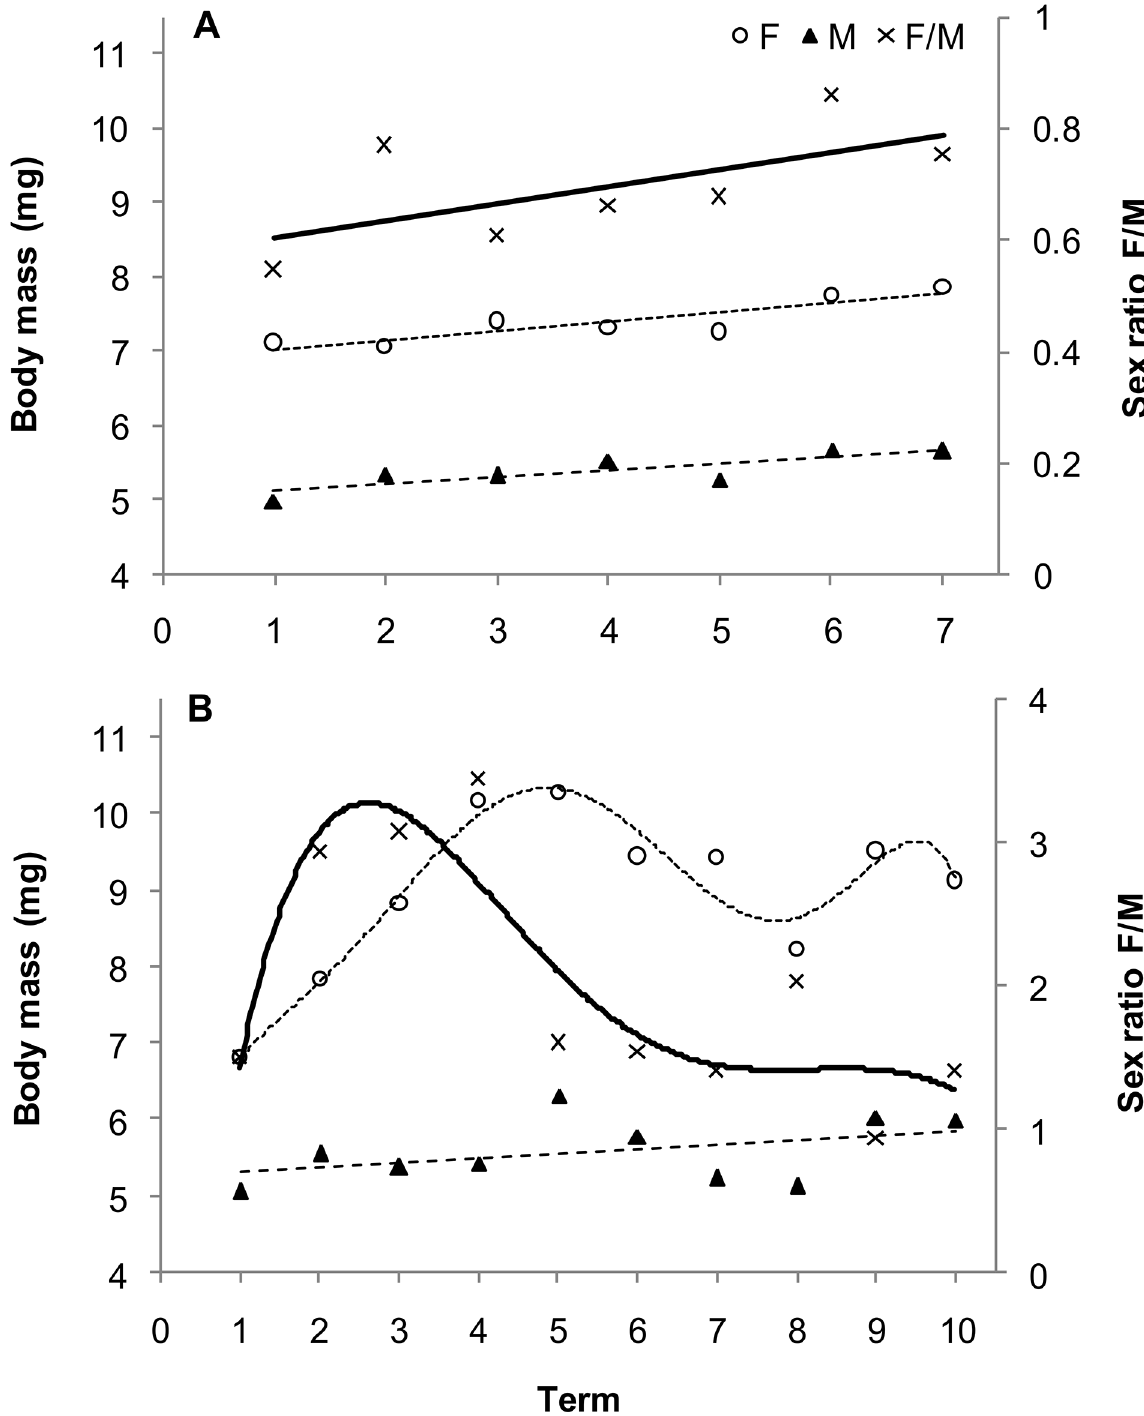
Fig 4. Body mass and sex ratio of current-year (A) and 1-year-old (B) Altica brevicollis coryletorum beetles over time. Numbers 1 – 7 and 1 – 10 indicate successive dates of insect collection (see Materials and Methods). One-way ANOVA was used to determine the effect of term on females (current-year, R 2 = 0.0824, P < 0.0001; 1-year-old, R 2 = 0.2530, P < 0.0001), males (current-year, R 2 = 0.0726, P < 0.0001; 1-year-old, R 2 = 0.1393, P < 0.0001), and the sex ratio (current-year, R 2 = 0.1028, P = 0.4779; 1-year-old, R 2 = 0.1545, P = 0.1955).